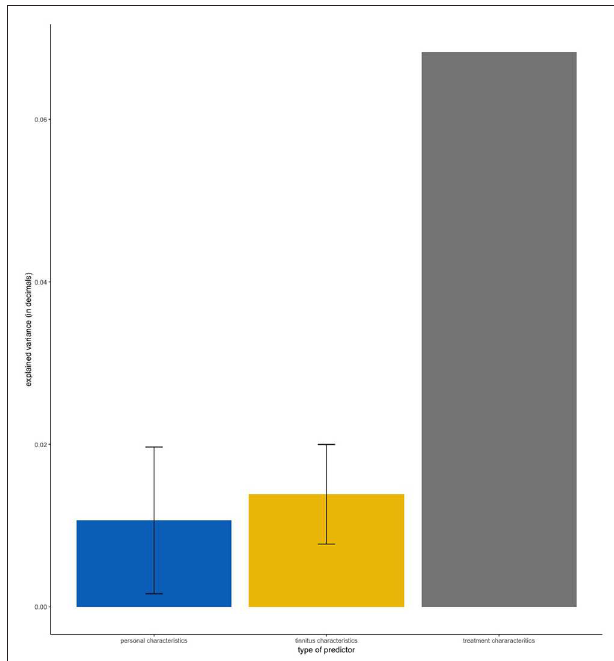
FIGURE 2 | Mean amount of variance explained by type of predictor. Error bars represent standard deviation. “Personal Characteristics” contains the predictors Age, Gender, and Tinnitus Onset. “Tinnitus Characteristics” contains the predictors Tinnitus Frequency, Laterality of Hearing Loss, Perception of Tinnitus, Reactiveness to Noise, Hearing Loss, Laterality of Tinnitus, Hyperacusis, and Jaw/Neck Problems. “Treatment Characteristics” contains the predictor Treatment